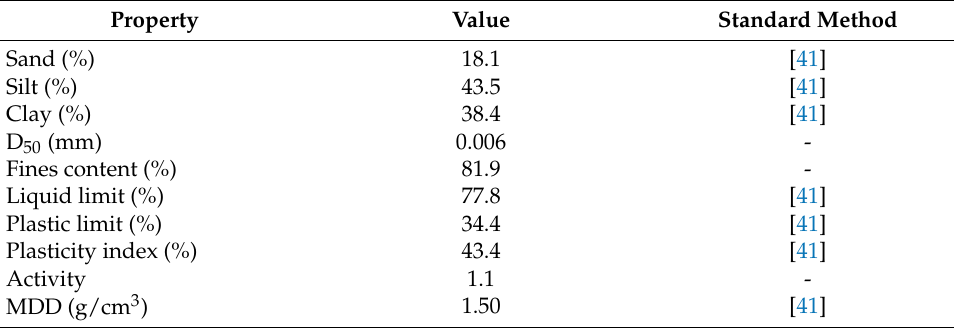
Table 1. Basic engineering characteristics of the marine